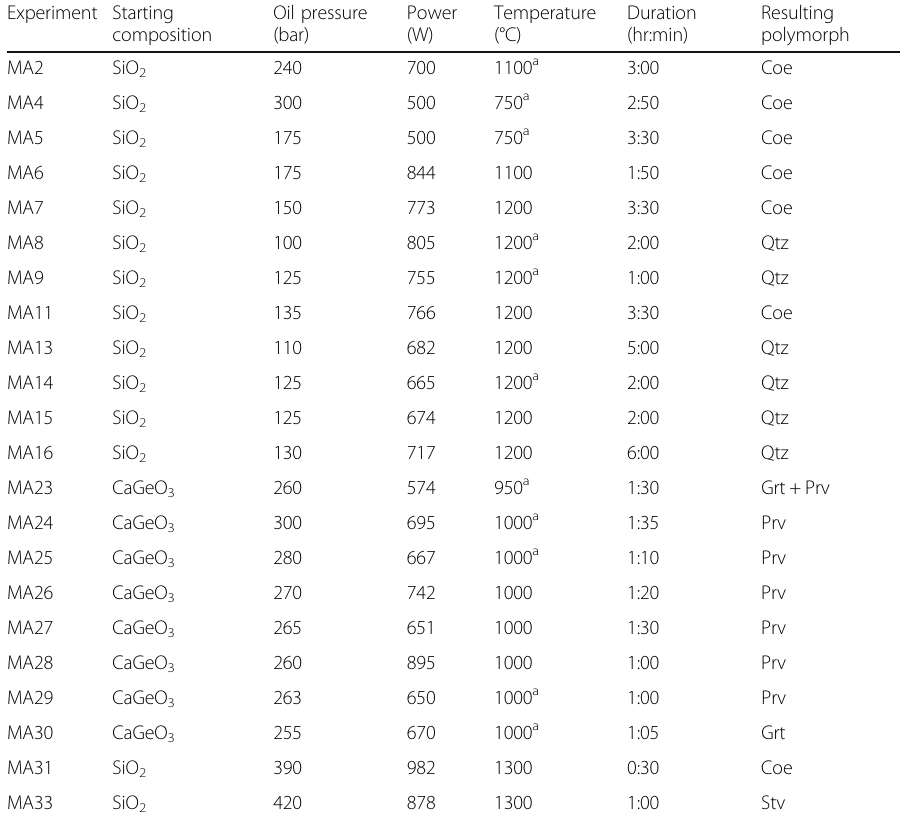
Table 1 a Thermocouple readout failed in these experiments. These temperatures have been estimated based on the power-temperature relationship of other experiments at similar pressures and carry an uncertainty of ±150